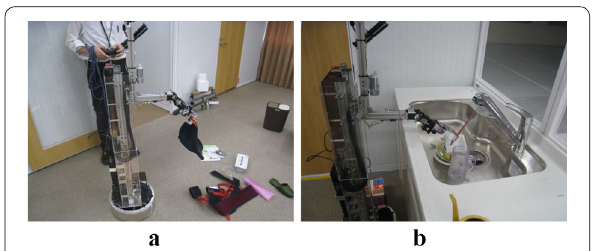
Fig. 7 Object handling by mock-up [46]. a Floor, b Kitchen